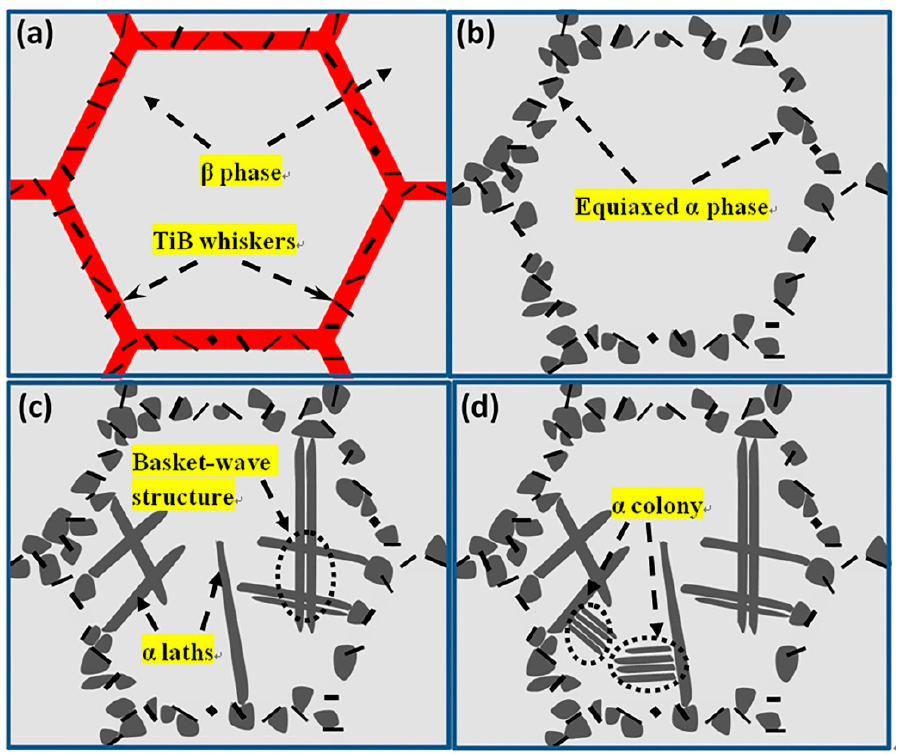
Figure 10. Schematic illustration of the microstructure evolution for the composite.